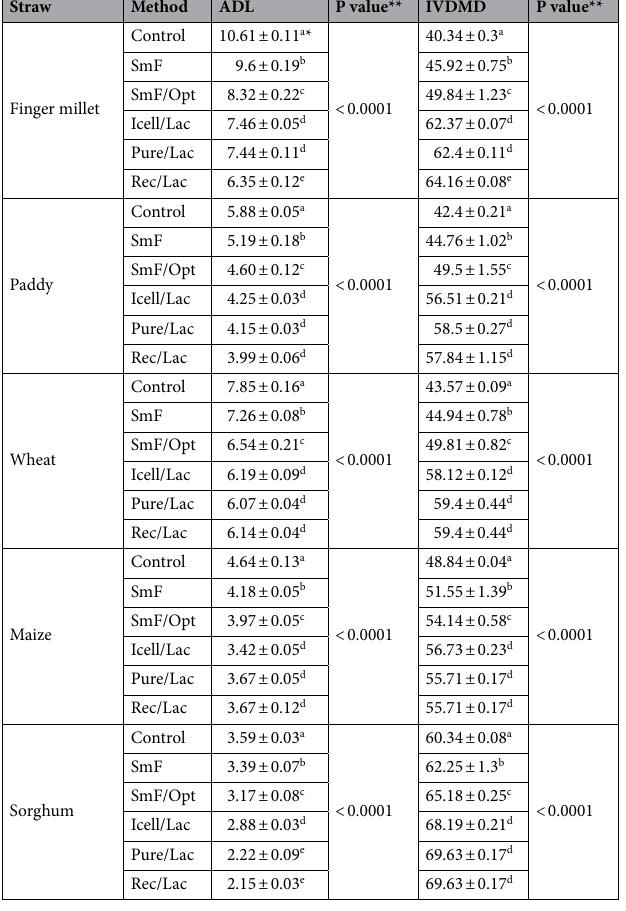
Table 1. Evaluation of ADL and IVDMD of crop residues treated with laccase obtained using different production methods. Variables with different superscripts within groups were found to be statistically significant. (p- value < 0.05 for t-test); ** statically significant if p- value < 0.05 (for